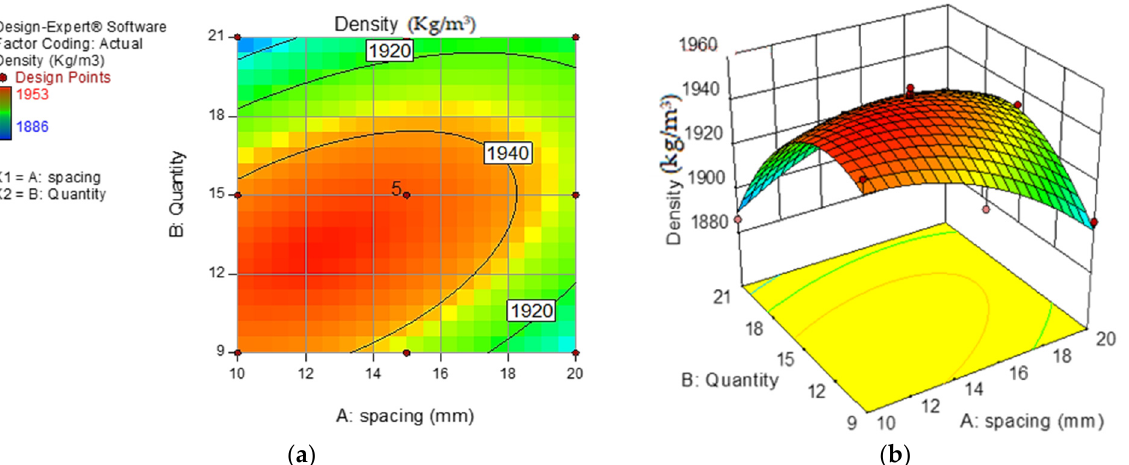
Figure 11. ( a ) Two ‐ dimensional contour plot; ( b ) Three ‐ dimensional response surface diagram for D model.